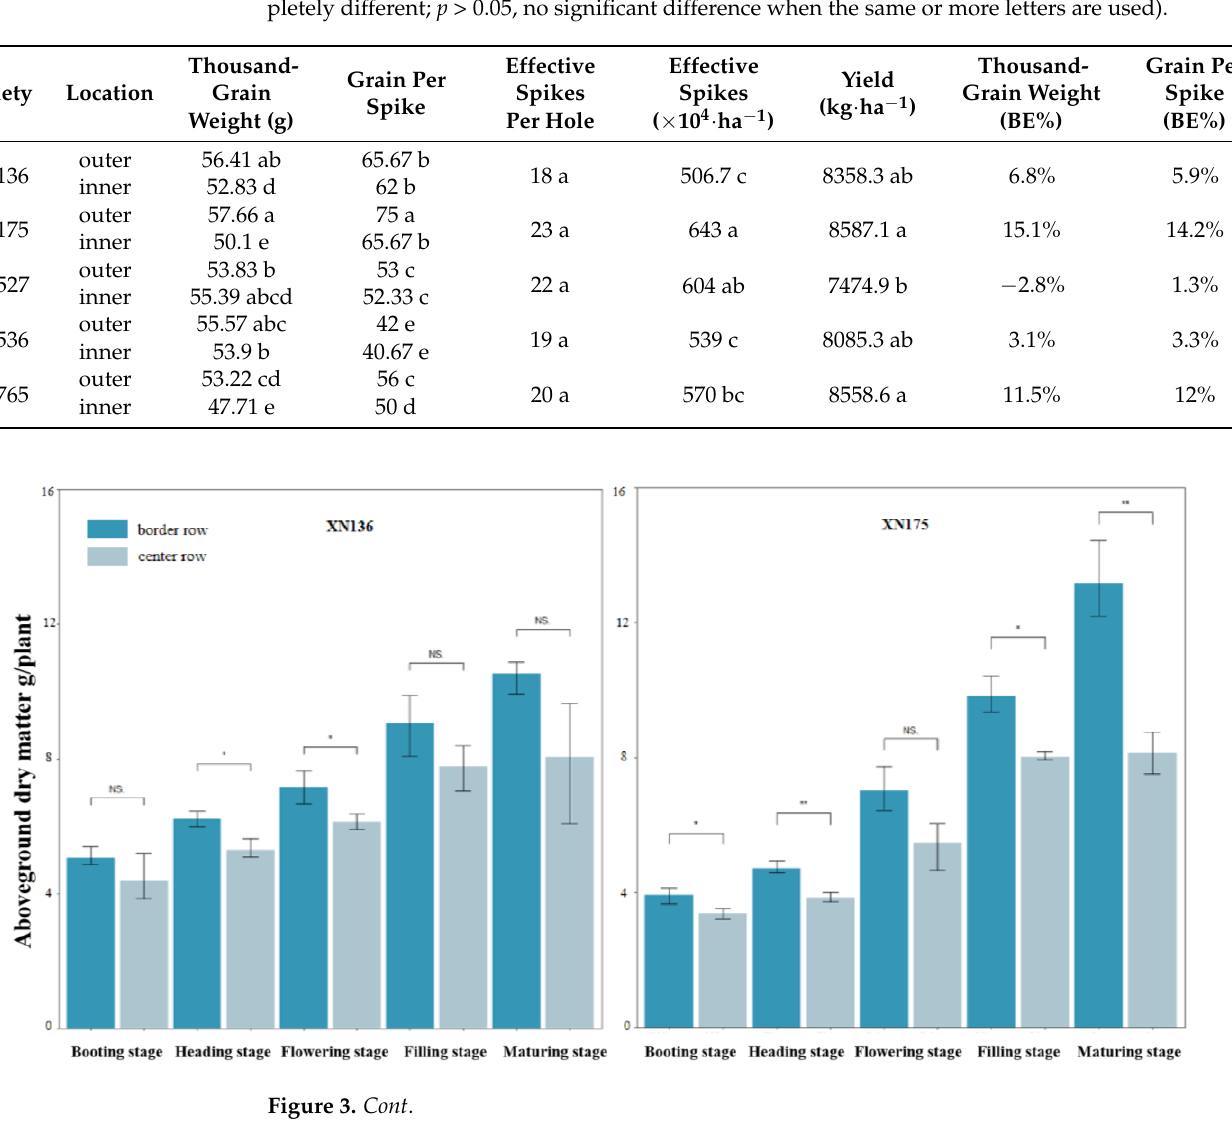
Table 1. Border effects of yield and yield components of wheat at maturity stage in 2021–2022 ( p ≤ 0.05, significant difference when the outline and inline characters of the same variety are com-